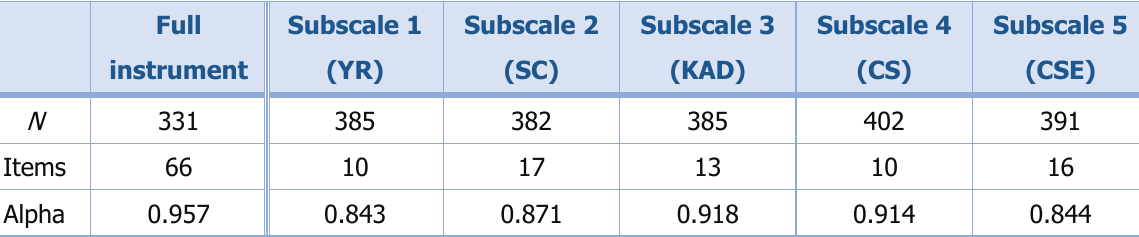
Table 3. Cronbach’s Alpha, 66 -Item Instrument — Round